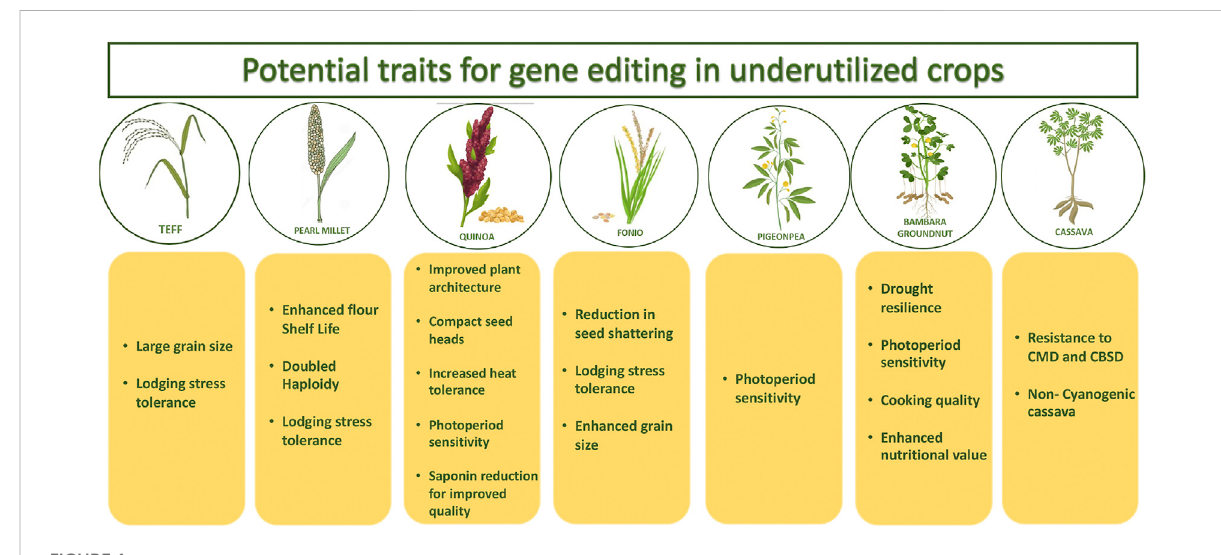
FIGURE 1 Schematic representation of the potential traits which can be explored in underutilized crops using gene editing